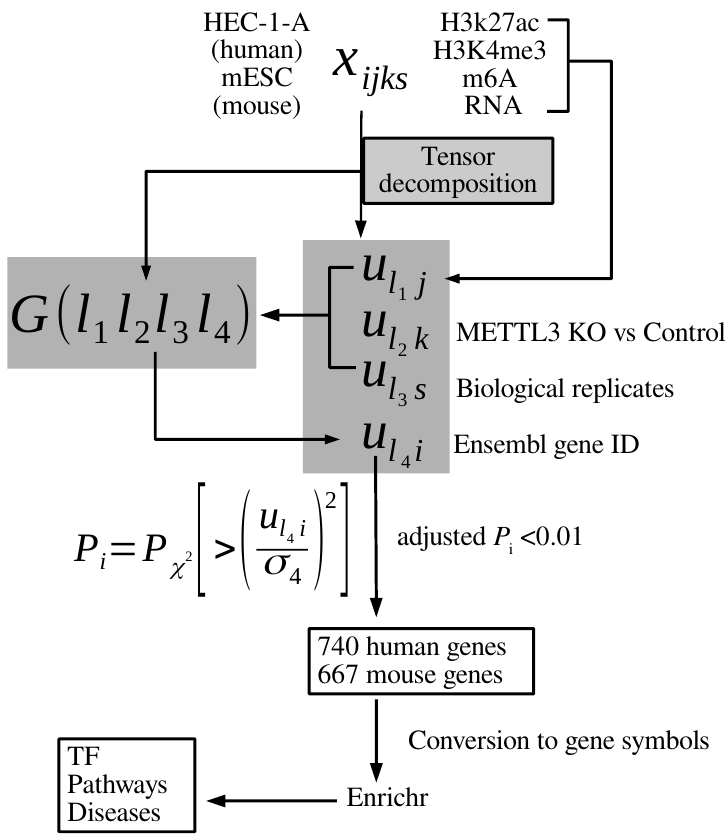
Figure 1. The flowchart of analyses performed in this